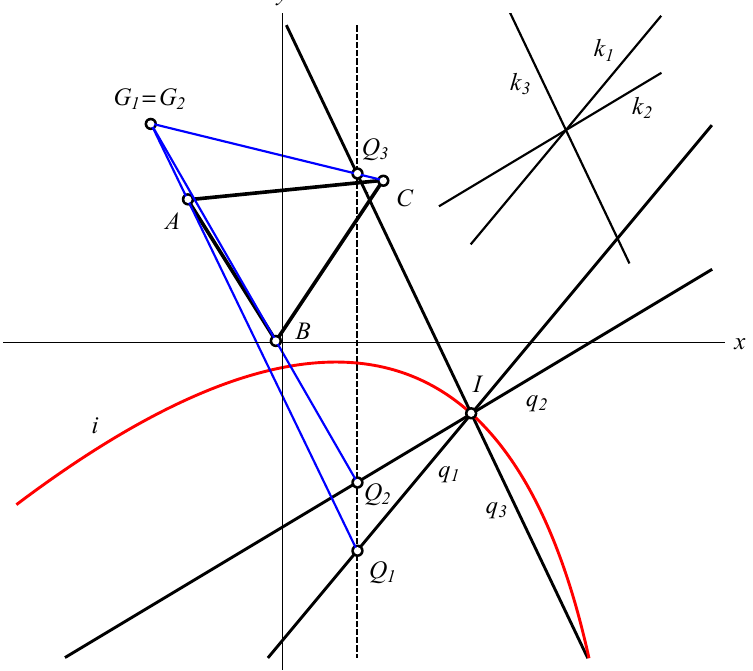
Figure 3. The locus i of all points I for which two generalized Gergonne points G 1 , G 2 of the triangle ABC in directions k 1 , k 2 , k 3